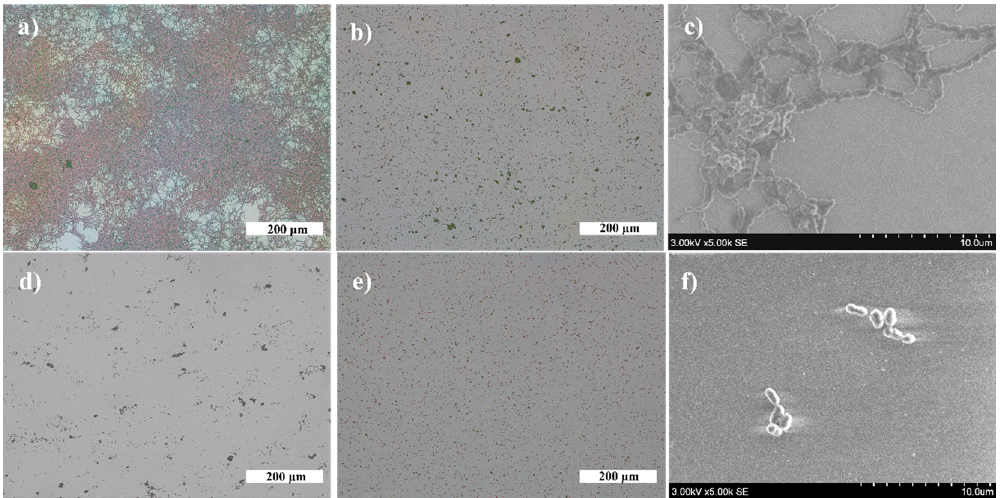
Figure 9. Adherence of bacterial cells on different surfaces (magnification of OM images ×10): ( a ) N. sicca on SiO 2 , ( b ) V. parvula on SiO 2 , ( c ) SEM image of N. sicca on SiO 2 , ( d ) N. sicca on TiO 2 , ( e ) V. parvula on TiO 2 , and ( f ) SEM image of V. parvula on SiO 2 .